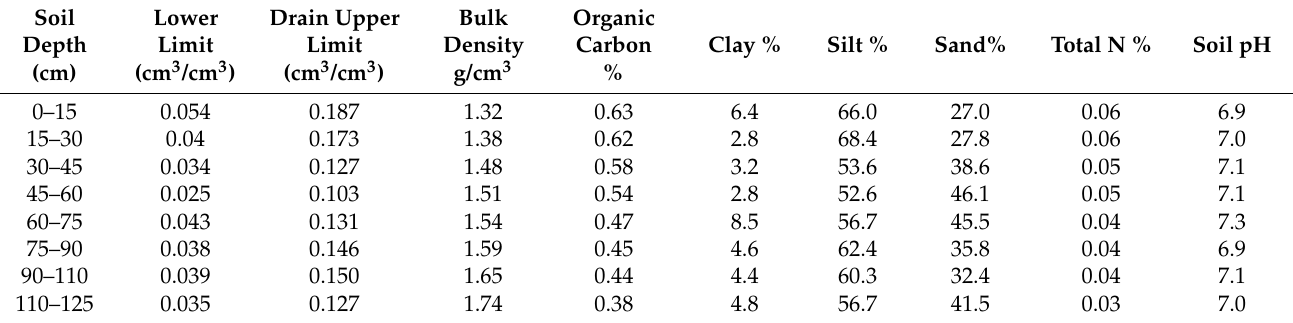
Table 1. Soil physical and chemical properties for the experimental